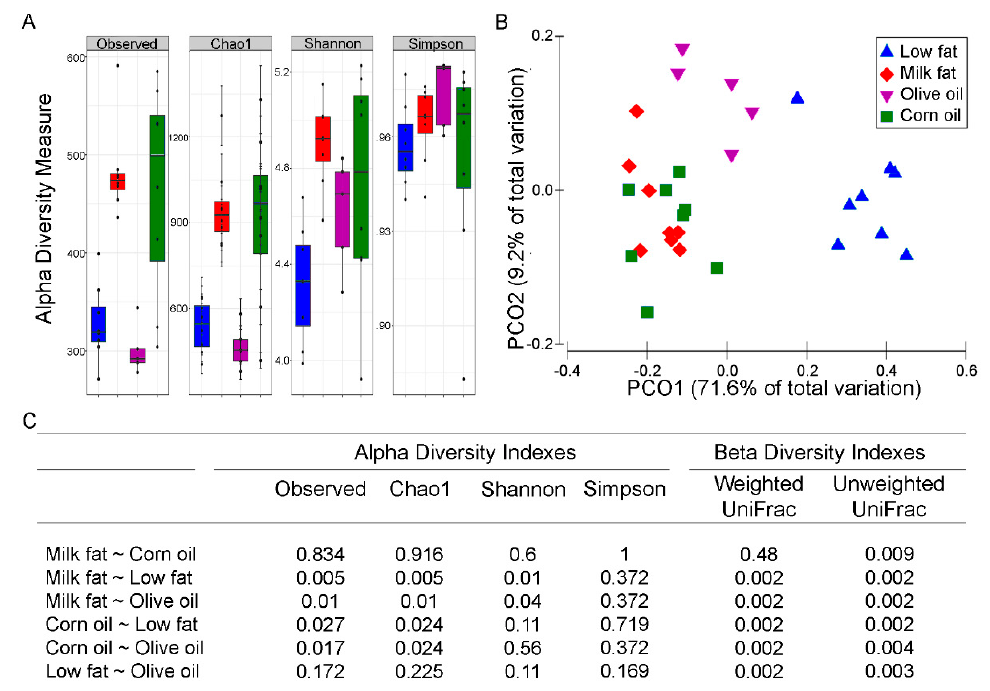
Figure 1. The effect of lipid diets on the diversity of the gut microbiota. ( A ) Alpha diversity of colonic microbiota from mice fed high fats diets composed of low-fat chow (blue), milk fat (red), olive oil (purple) or corn oil (green). Observed species richness, Chao1, Shannon’s, and Simpson’s indexes are displayed. ( B ) PCoA plot of the weighted UniFrac distances of colonic microbial communities from mice fed high-fat diets composed of milk fat, olive oil, corn oil or low-fat chow. The first two principal components from the PCoA are plotted. ( C ) Statistical summary ( p- values after Benjamini–Hochberg adjustment for multiple comparisons) of all alpha and beta diversity measures.